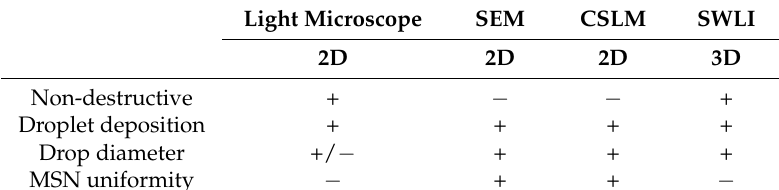
Table 4. Characterization methods for drop deposits.